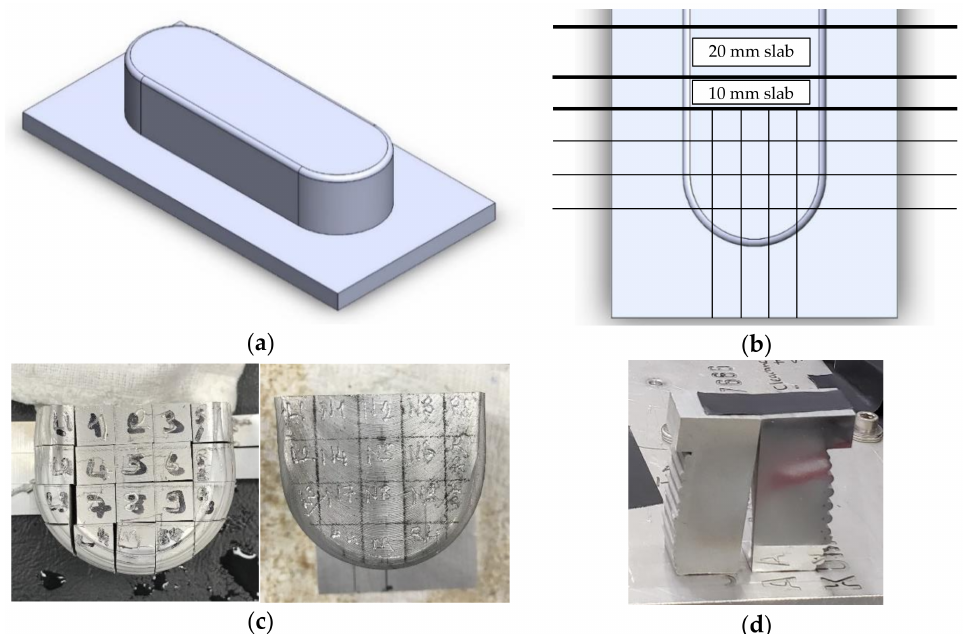
Figure 3. ( a ) Schematic figure of the stadium-shaped blocks made by MELD method; ( b ) Wire EDM cutting lines on the original block; ( c ) Cutting layout of samples; left: sample A, right: sample B; The cross-section of each numbered bar shown is 10 mm by 10 mm; ( d ) The 20 mm slab from Sample B is cut in half and one of the halves is polished to improve the quality of the neutron interferometry imaging for detecting internal neutron dark-field (scattering) features. The thickness of the build plate is 1 / 2 inch. Table 1. Process parameters of MELD samples. Parameter Ingot A Ingot B Spindle speed